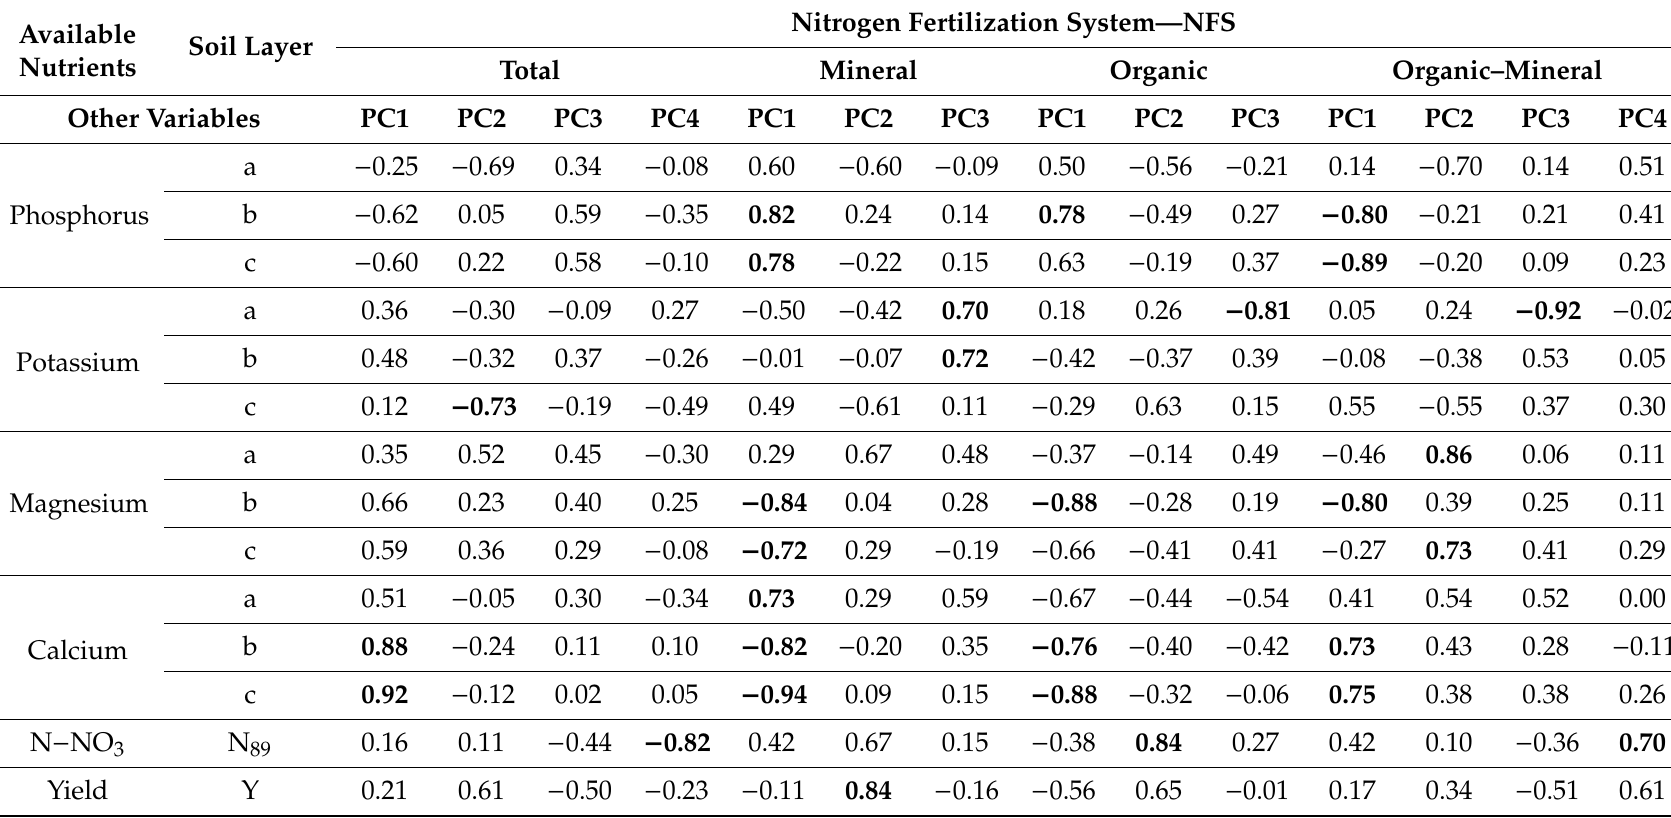
Table A4. Principal component analysis of the content of available nutrients and nitrate nitrogen, and yield at physiological maturity (BBCH